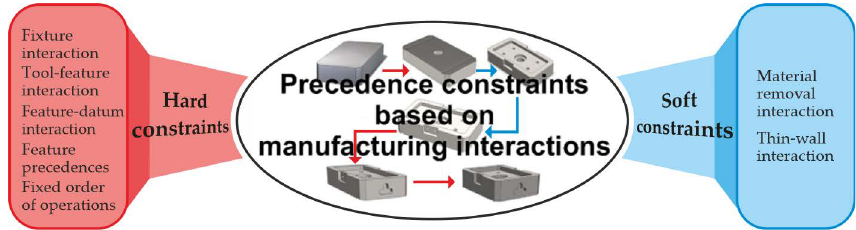
Figure 2. Schematic representation of precedence constraints.